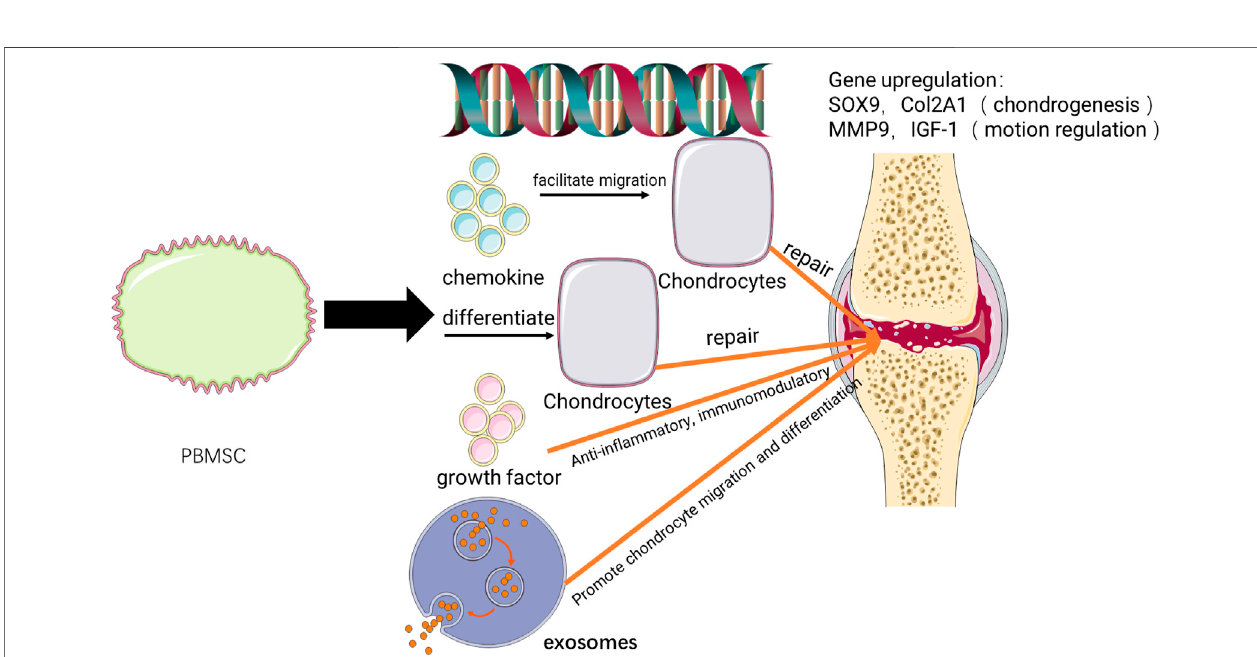
FIGURE 5 | Basic biology of blood-derived stem cells. MNC, mononuclear cells; BMSC, Bone marrow mesenchymal stem cells; PBMSC, peripheral blood mesenchymal stem cells; PBMNC, peripheral blood mononuclear cells; and PBMPC, peripheral blood mesenchymal progenitor cells.